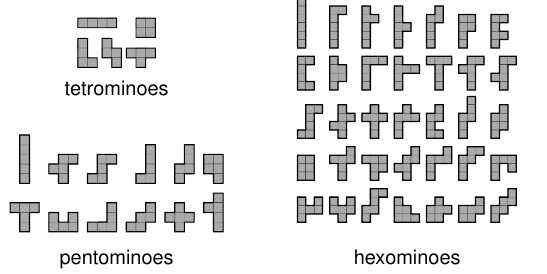
Figure 3. Polyominoes of four (tetrominoes), five (pentominoes) and six (hexominoes) elements. When rotations and reflections are not considered, there are 5 tetrominoes, 12 pentominoes and 35 hexominoes, as shown here. When rotations and reflections are also considered distinct, there are 19 tetrominoes, 63 pentominoes and 216 different hexominoes. Eq. (6) gives the right order of magnitude of these numbers: 21 . 6 for tetrominoes, 70 . 1 for pentominoes, and 237 . 4 for